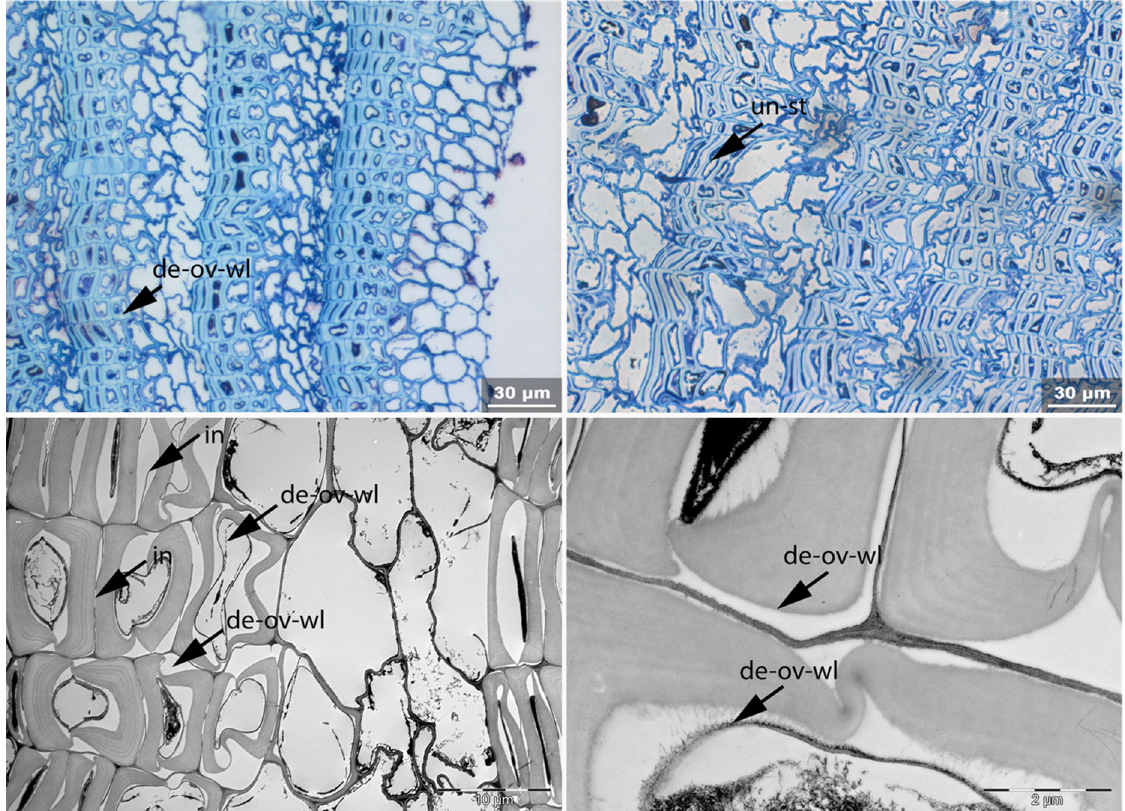
Figure 21. Sample 4a. Detachment of secondary cell wall from compound middle lamella is found throughout (de-ov-wl, top left). Elongation of thick-walled cells (un-st) is present (top right). TEM (bottom left) shows detachments of secondary wall from compound middle lamella and tertiary wall (de-ov-wl). Very thin, delaminated tertiary cell wall layer is present as a ring within the lumen. Compound middle lamella is broken and shows large interruptions (in). Swelling caused wave deformation of secondary wall layer. Separation and threadlike structures appear between secondary and tertiary wall (bottom right). Original structure of suberin lamella has disappeared and broad light and dark bands with the same ori- entation as the former suberin lamella are formed.